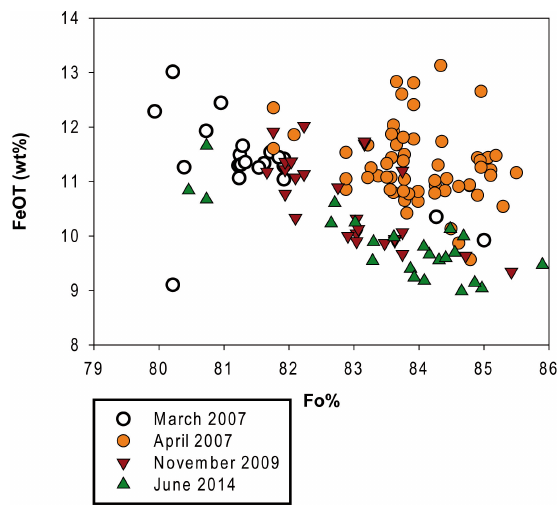
Figure 9. FeO T in melt inclusions as a function of forsterite (Fo) content of the olivine host for recent eruptions at Piton de la Four-